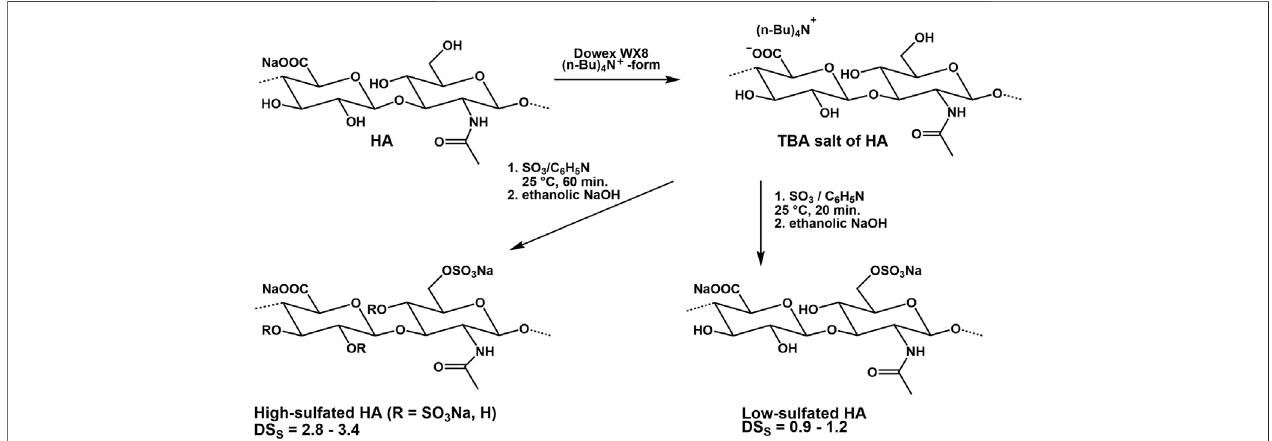
FIGURE 6 | Synthesis of high- and low-sulfated